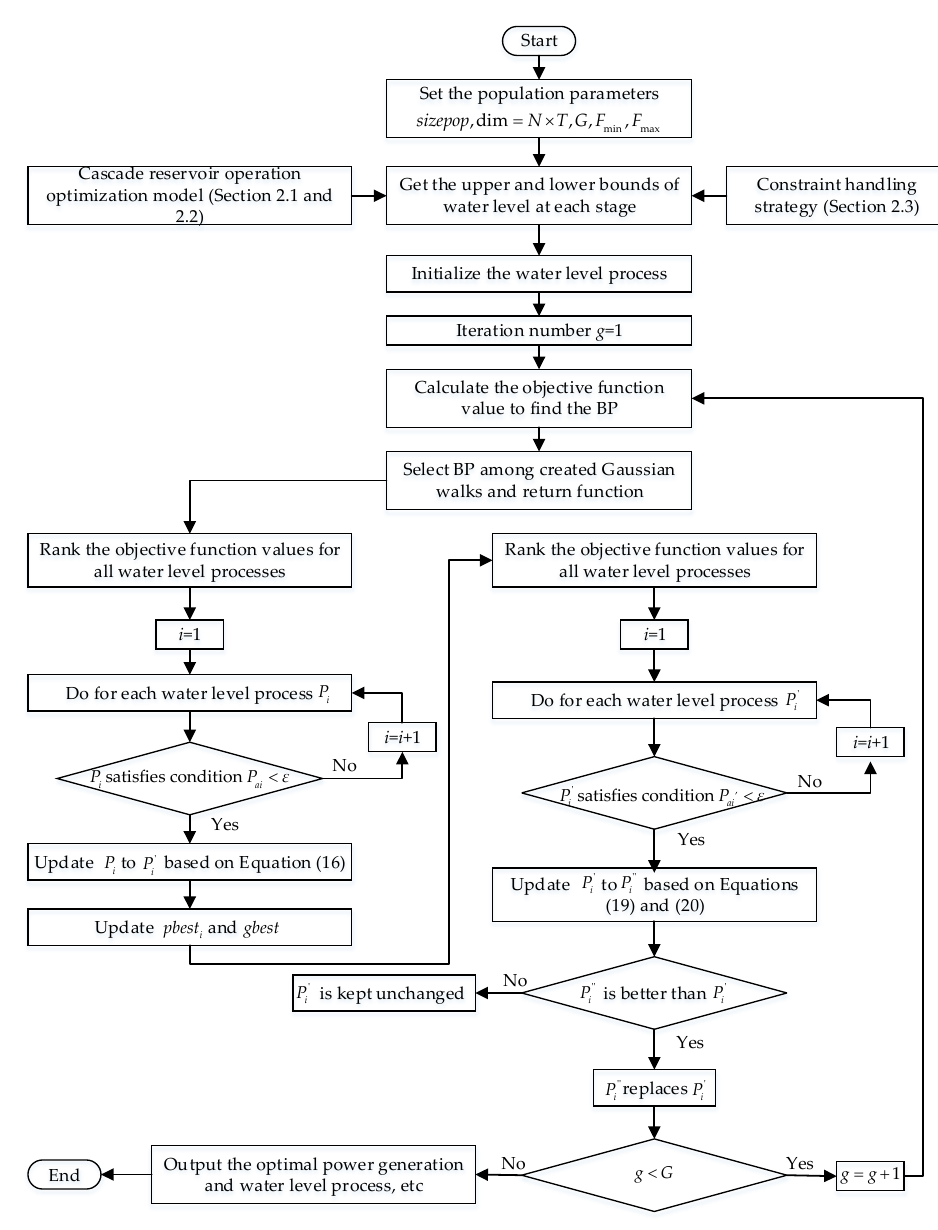
Figure 2. Flowchart of the procedure for solving the problem of the optimal operation strategy using the ISFS algorithm.